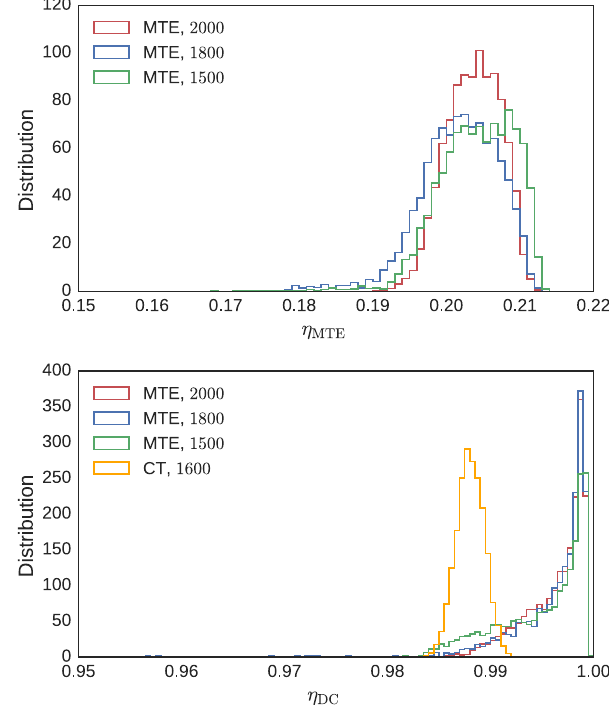
FIG. 12. Upper: Histogram showing the distribution of the MTE efficiency. Bottom: Histogram showing the distribution of the DC efficiency including CT data. The typical intensity values are in units of 10 10 ppp at extraction from